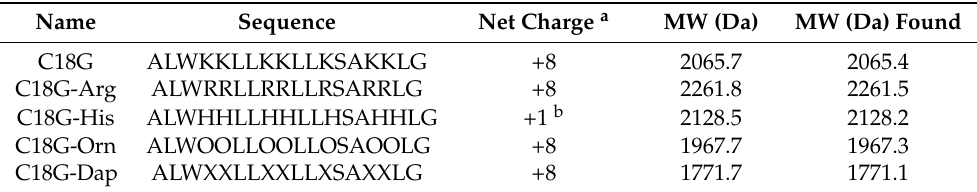
Table 1. Peptide Sequences.